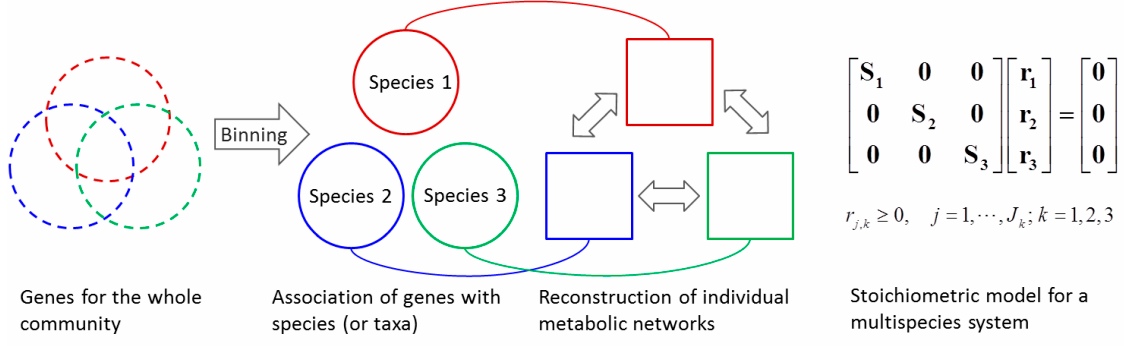
Figure 6. Procedures of developing a stoichiometric model for a simple microbial consortium. The metabolic networks and stoichiometric models for individual species are reconstructed based on species-level genes assigned through the binning process. The size of the resulting community stoichiometric model is increasing in proportion to the number of